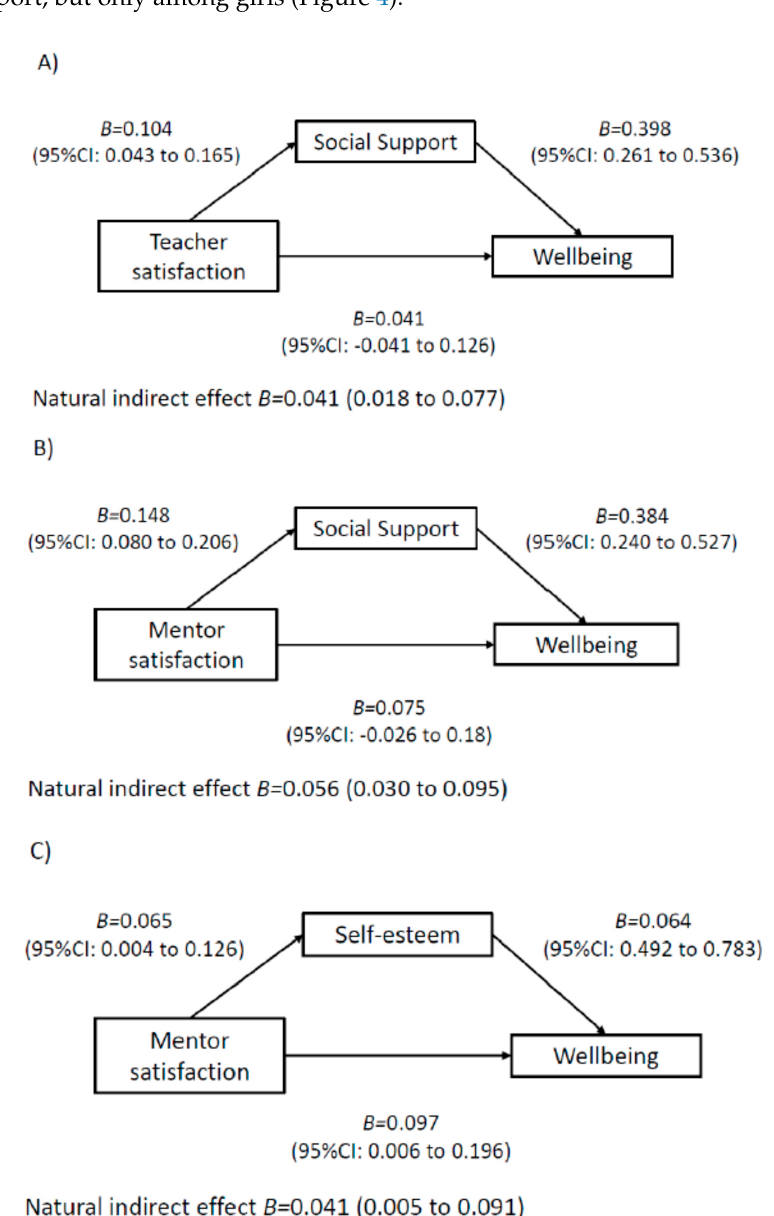
Figure 1. Mediation models of potential psychological mediators in the association between intervention components and wellbeing among boys . Note. Adjusted for age, ethnicity, language, school, BMI z-score and baseline values of change variables. CI, confidence interval. E-values estimates (in relative risk): Model A : E-value: 1.26, Model B : E-value: 1.33, Model C : E-value: